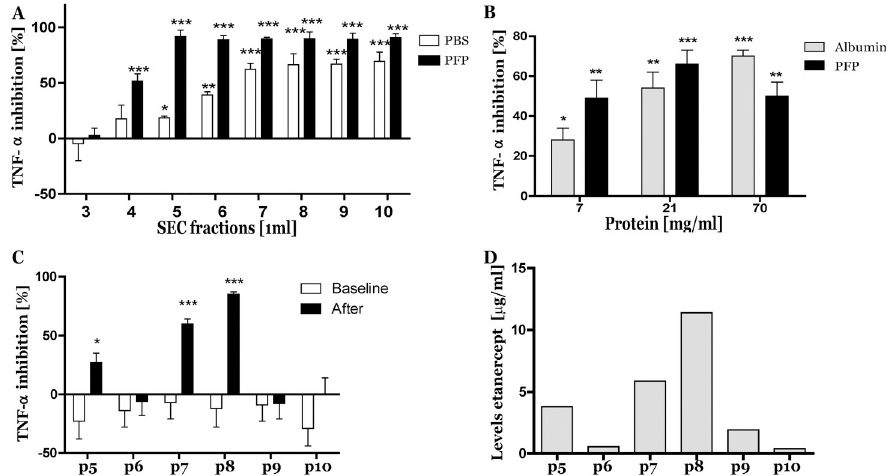
Fig 2. Presence of plasma proteins leads to co-isolation of etanercept in the SEC pEV fraction. Etanercept (1 μ g/ml) in PBS alone or with pfp was SEC isolated. In each eluted SEC fraction, TNF- α inhibition was measured in triplo (A). Etanercept (1 μ g/ml) in the presence of 3 different concentrations pfp (10-20-100%) or equal protein levels of albumin (7-21-70 mg/ml) was SEC isolated. In Fraction 5 (pEV fraction) TNF- α inhibition was measured in triplo (B). Next, levels of etanercept were measured in plasma of 6 new etanercept treated RA patients (C). Finally, in these RA patients neutralization of TNF- α was measured in triplo on SEC isolated pEVs before (white bars) and after (black bars) etanercept treatment (C). Statistically significant differences in TNF- α reduction versus control (only TNF- α without pEVs), were determined by Mann-Whitney test, � p < 0.05, �� p < 0.01, ��� p < 0.001.